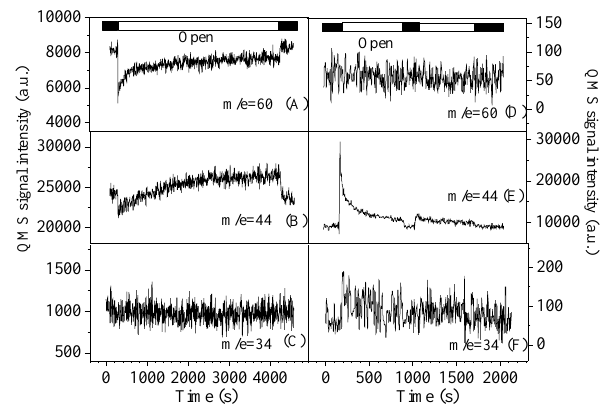
Fig. 1. The heterogeneous reaction of OCS on 100.4 mg of CaO at 300 K (left side) 627 and the in situ desorption of surface species in the end of uptake (right side). 628